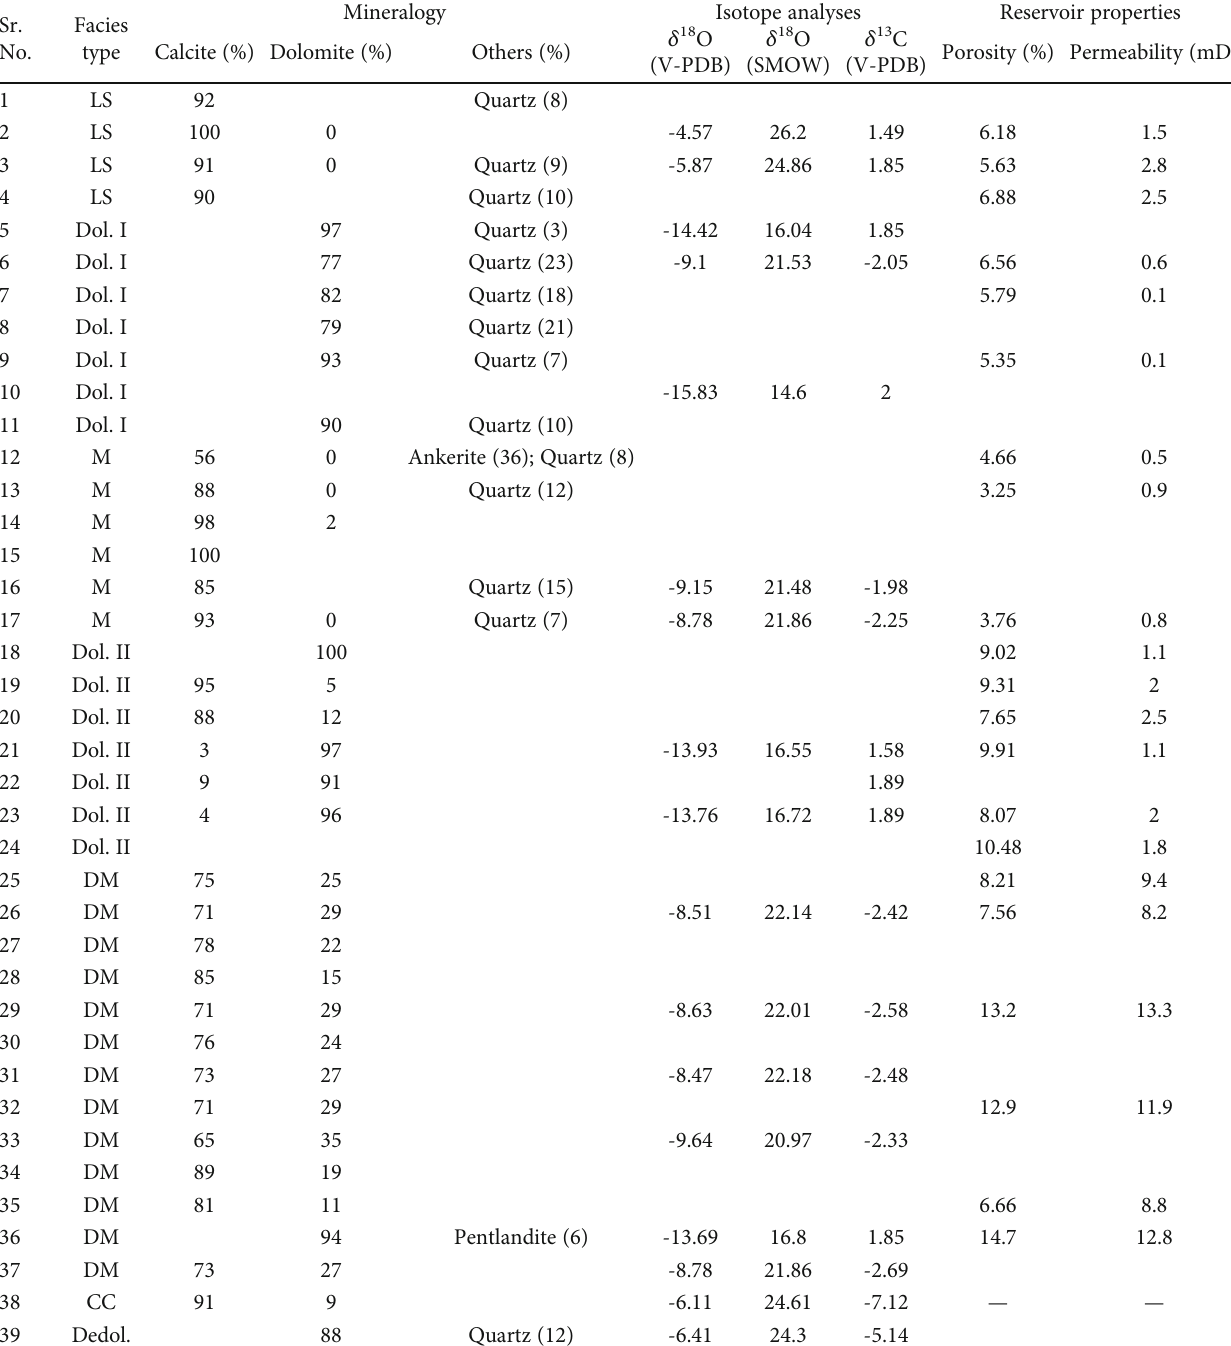
Table 1: Data set of various diagenetic phases showing mineral composition in percentage, carbon and oxygen isotopes, and porosity/permeability data. LS: limestone, DM: dolomitic marble, M: marble, CC: calcite, Dedol: dedolomite.